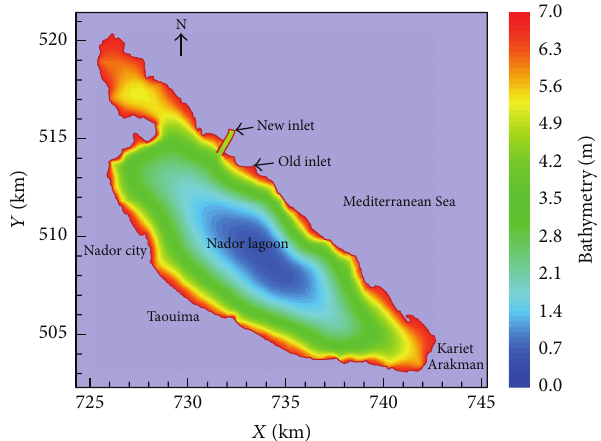
Figure 1: Location and bathymetry of the Nador lagoon study